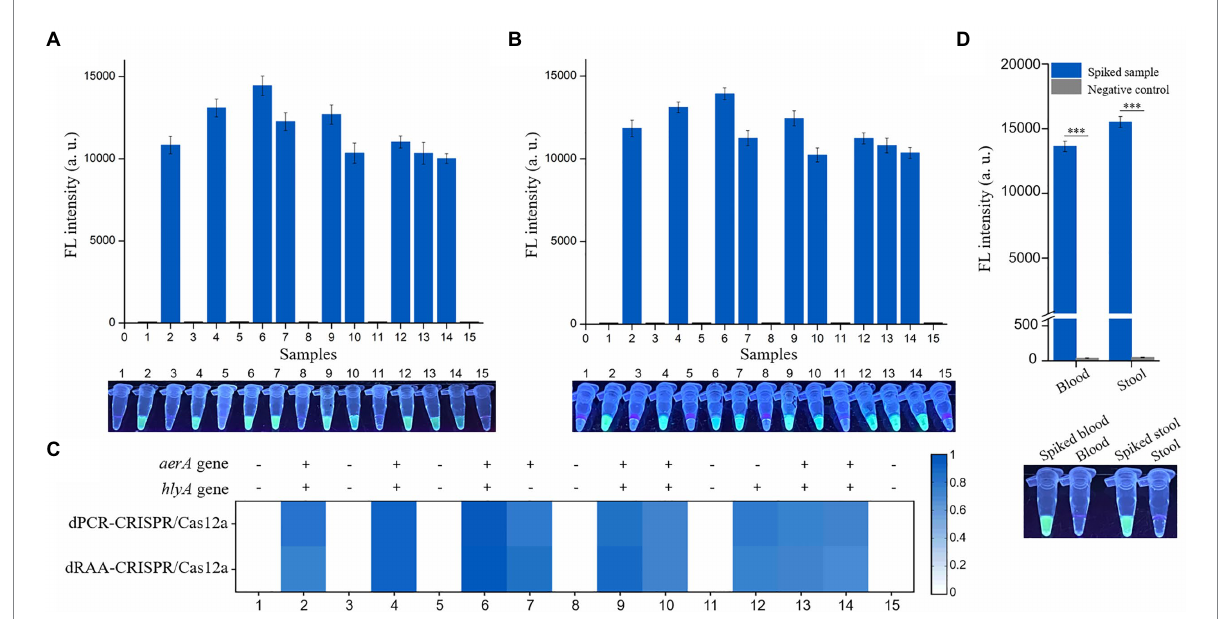
FIGURE 6 Practicability evaluation of the dRAA-CRISPR/Cas12a and dPCR-CRISPR/Cas12a assays in the detection of spiked samples. Six normal liver samples and nine liver samples spiked with 1 × 10 3 CFU of A. hydrophila were used to extract genomic DNA according to the NaOH-based method. These genomic DNA samples were detected using dRAA-CRISPR/Cas12a (A) and dPCR-CRISPR/Cas12a (B) assays. n = 3 technical replicates; bars represent mean ± SEM. (C) Heatmap of the results of the two assays for the detection of A. hydrophila from 15 crucian carps. (D) Human blood and stool samples were spiked with 1 × 10 3 CFU of A. hydrophila ( aerA + hlyA + ). Normal blood and stool samples were served as negative controls. The fluorescence signals were read using an UV flashlight (below) or a multifunctional microplate reader (upper). n = 3 technical replicates; two-tailed Student’s t test; *** p < 0.001; bars represent mean ±